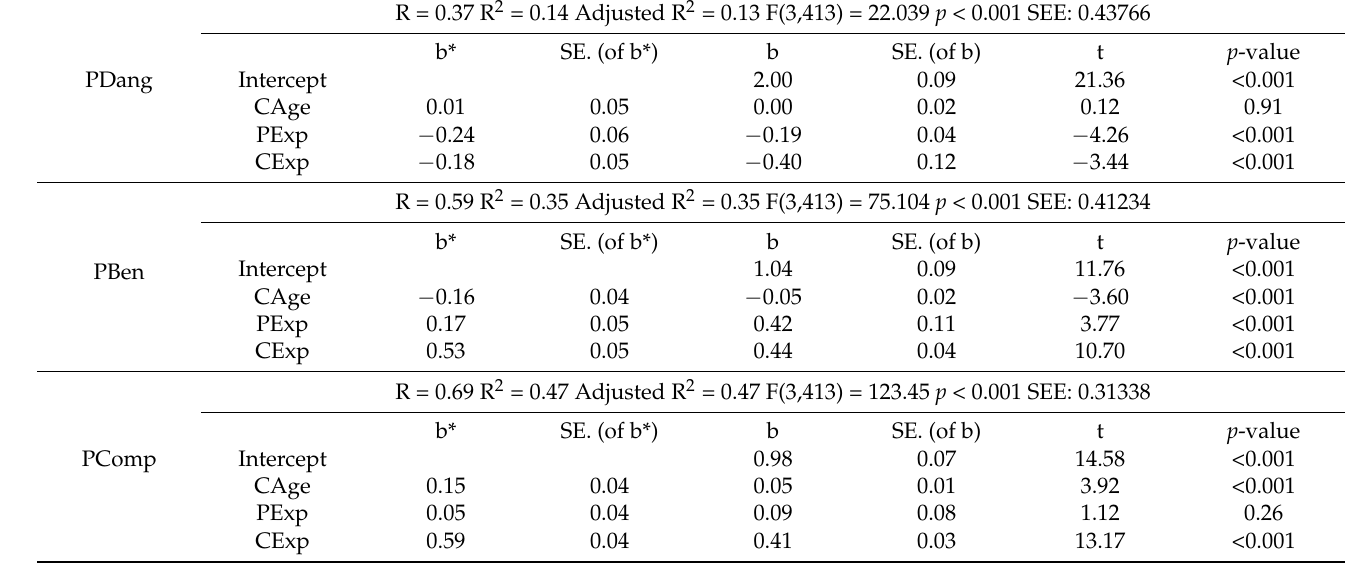
Table 5. Linear regressions modelling the effects of child age (CAge), parent experience (PExp), and child experience (CExp) on parents’ representations: perceived benefits (PBen), perceived dangers (PDang), and perceived competence (PComp).